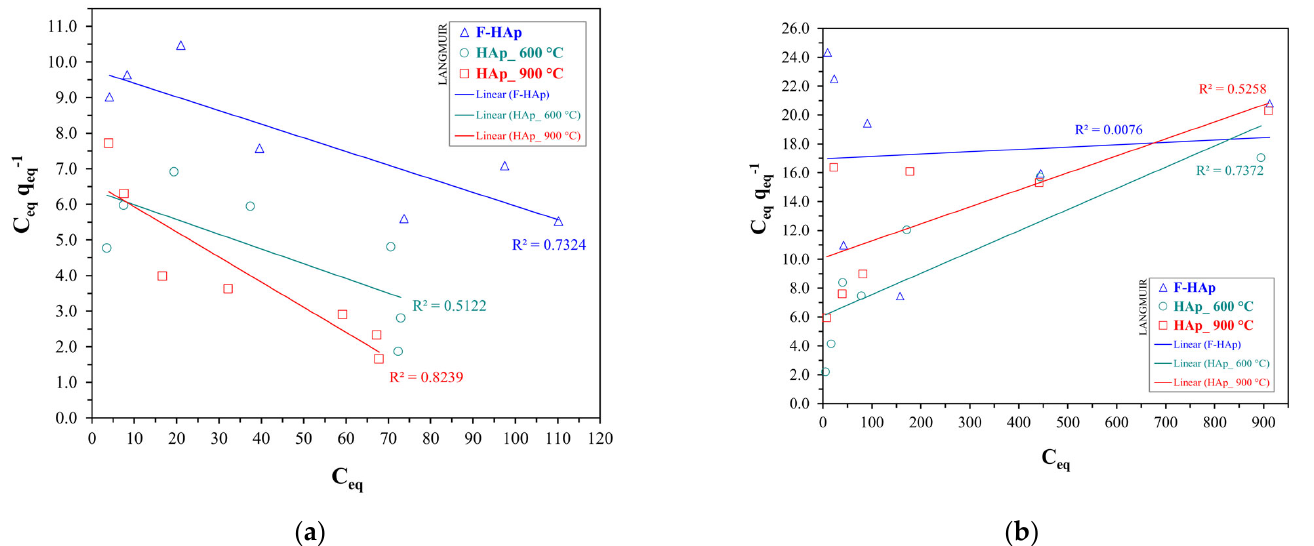
Figure 10. Linear fitting plots of Langmuir isotherm model for ( a ) atrazine and ( b ) cobalt adsorp ‐ tion.